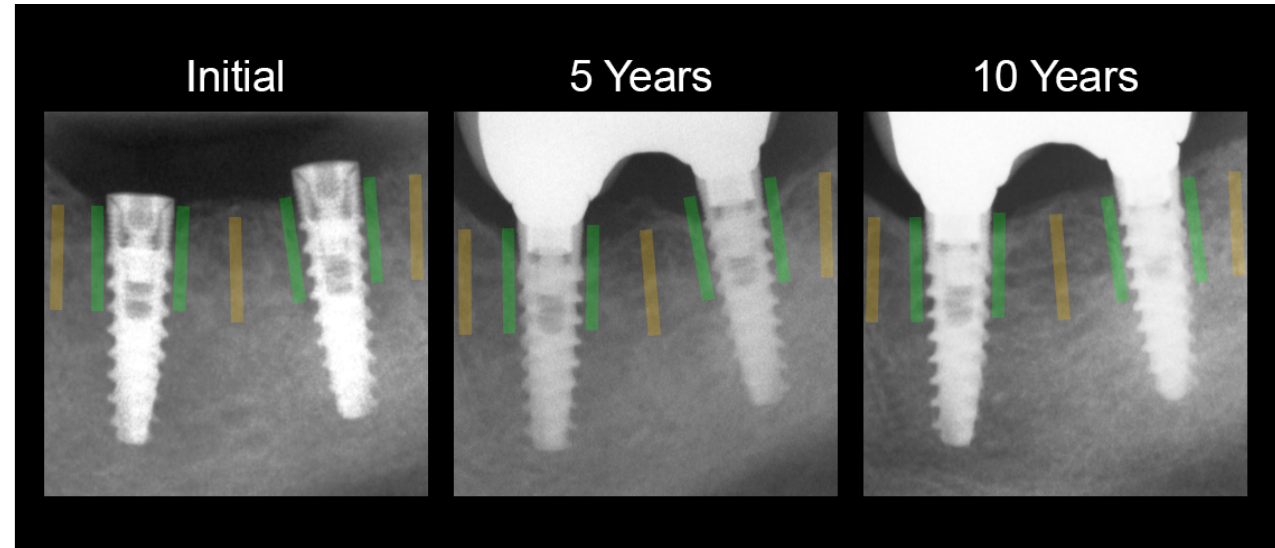
Figure 2. Image data acquisition method for texture analysis in intraoral radiographs. ROIs highlighted in yellow are sites in the alveolar crest distant from the dental implants (reference). ROIs marked in green are sites examined along the neck portion of the implants and represent, respectively: radiographs taken immediately prior to prosthetic work — initial ROI; radiographs taken after five years of functional loading — 5 years ROI; radiographs taken after ten years of functional loading — 10 years ROI. The data extracted from these ROIs were later analyzed in freeware MaZda 4.6 [79,80,82] and used to calculate the corticalization index.